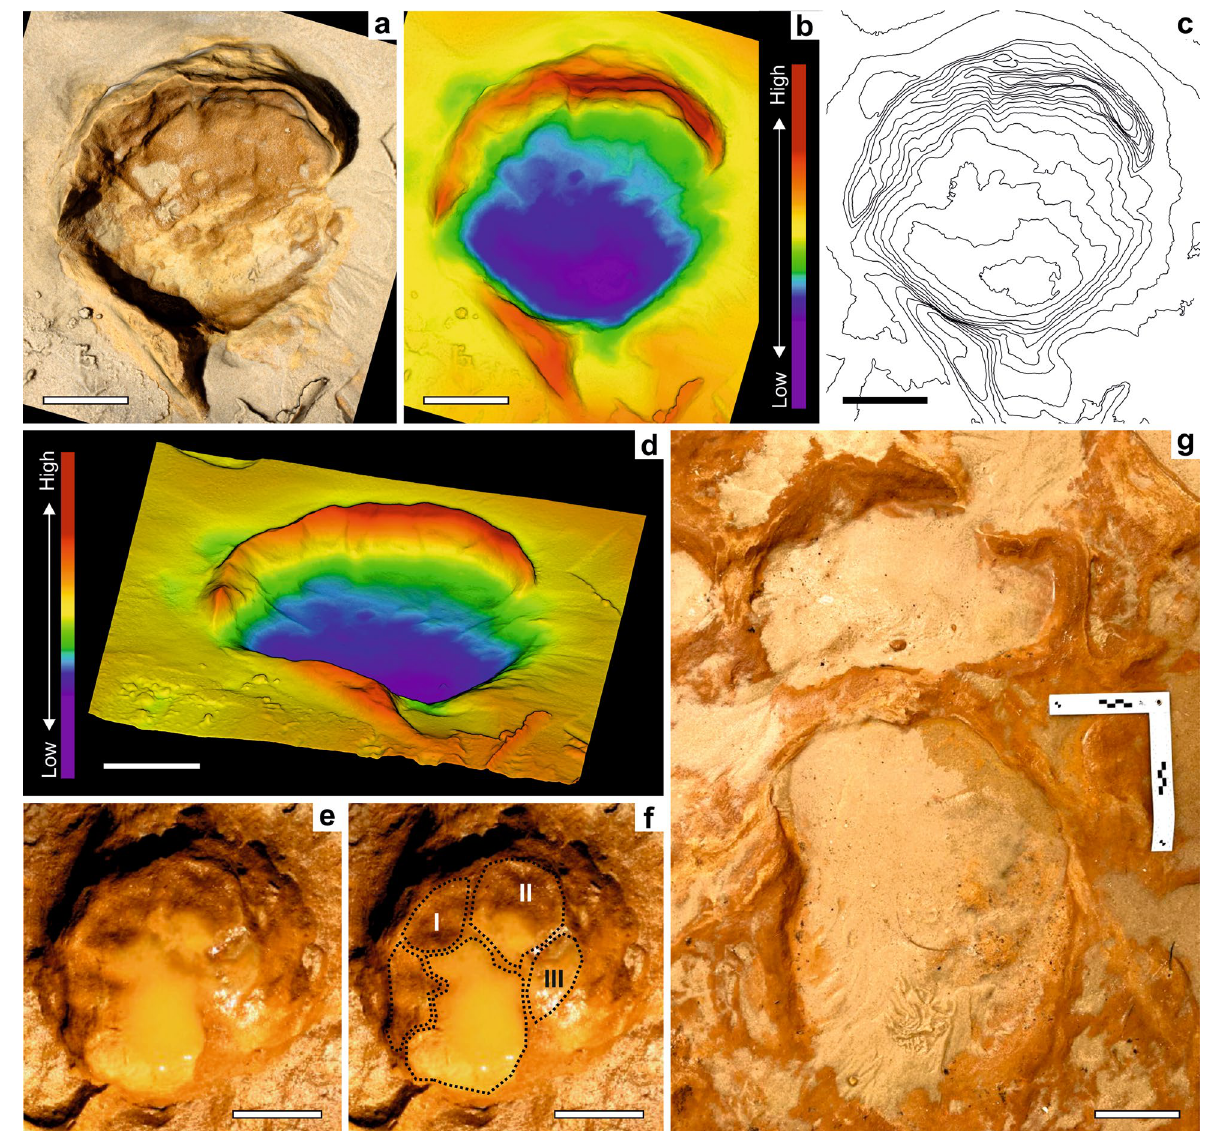
Figure 4. Large-sized Proboscipeda tracks attributed to P. antiquus adults. ( a ) to ( d ) PAT/MTS/001: Right manus showing clearly 5 toe impressions and the frontal and lateral displacement rims (morphological interpretation based on the orthogonal ( b ) and oblique ( d ) depth and contour ( c ) maps). ( e ) and ( f ) PAT/ MTS/010e: Deeper manus with pockmarks; toe pad impressions indicated (I–III). ( g ) PAT/MTS/004a,b: large manus-pes couple where the hind foot deformed the fore foot during overstepping, and revealing a typical elephantine gait; the toe impressions in both tracks indicate the direction of movement. Scale bar = 10